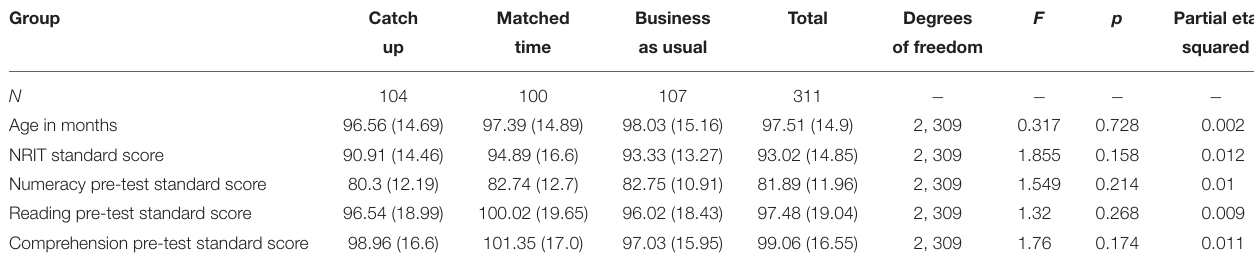
TABLE 2 | Post-test scores in all groups and results of ANOVAs comparing groups. Group Catch Matched Business Total Degrees F p Partial eta up time as usual of freedom squared N − Reading post-test standard